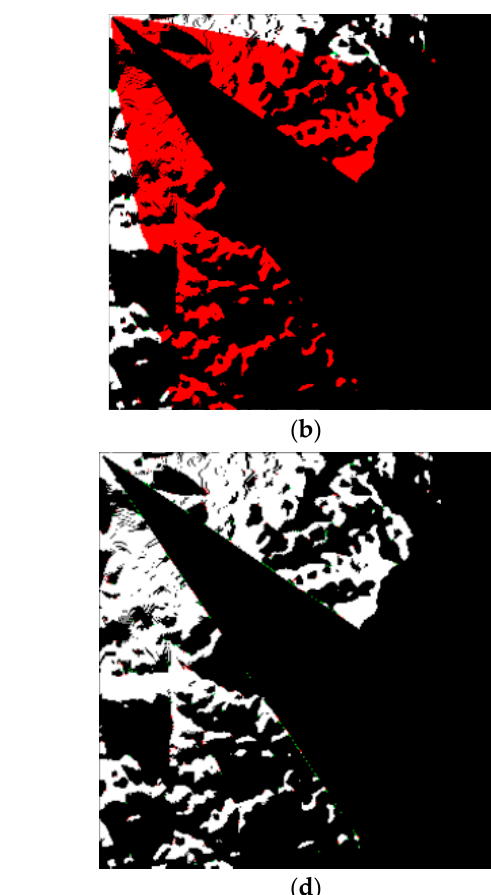
Figure 10. Partial viewsheds of different algorithms corresponding to the red rectangle in Figure9. These viewsheds are generated by ( a ) R2, ( b ) XDraw, ( c ) 10-BT and ( d ) HiXDraw, respectively. Red means visible areas are wrongly determined as invisible and green means invisible areas are wrongly determined as visible.